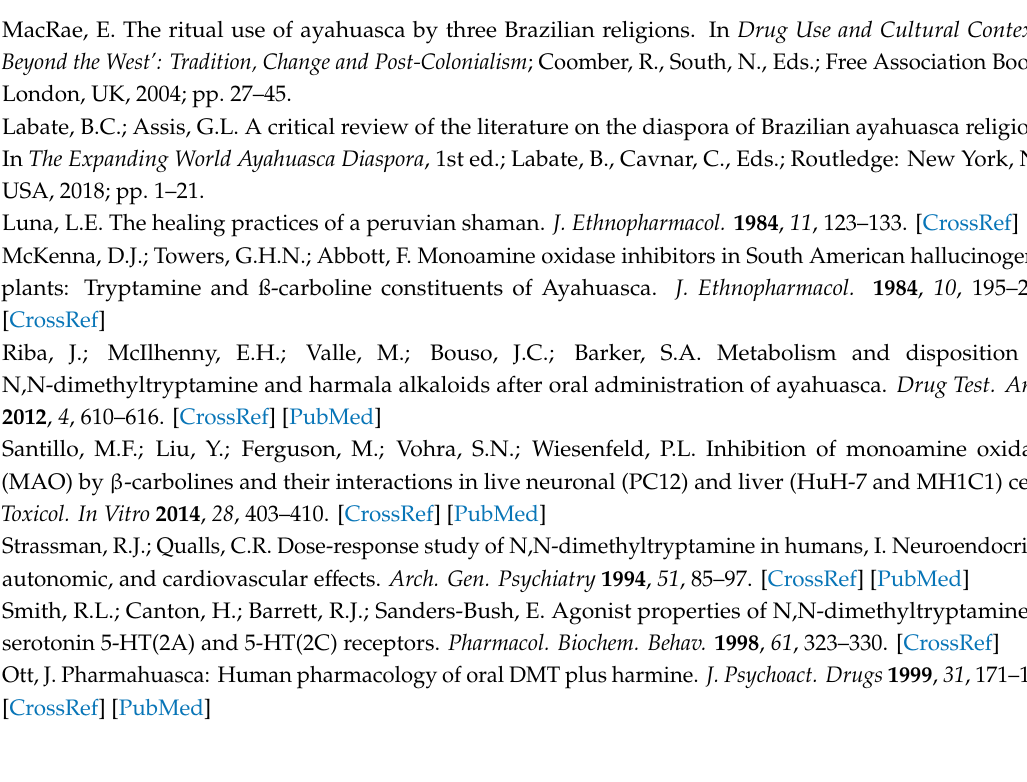
Table S1: Samples of Banisteriopsis ssp. and Diplopterys pubipetala and β -carboline concentrations. Table S2: Ayahuasca brew samples and alkaloid concentrations. Table S3: Optimized ESI + MS / MS parameters, chromatographic retention times and ion ratios in the LC-MS / MS method for the target analytes in B. caapi extracts and ayahuasca. Table S4: Recovery and repeatability ( n = 3 for DMT and n = 5 for the others) and intermediate precision ( n = 8) obtained for the analysis of Malpighiaceae extracts and ayahuasca samples at three concentration